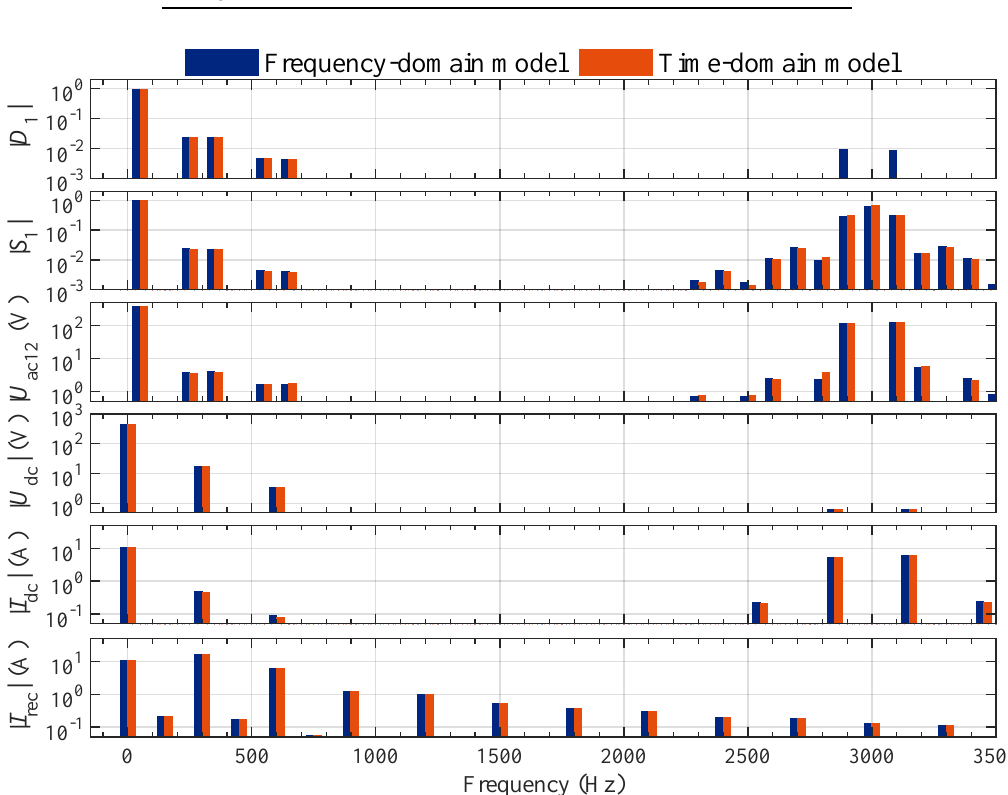
Figure 11. Comparison of the results for closed-loop control using the frequency-domain model (blue) and the time-domain model